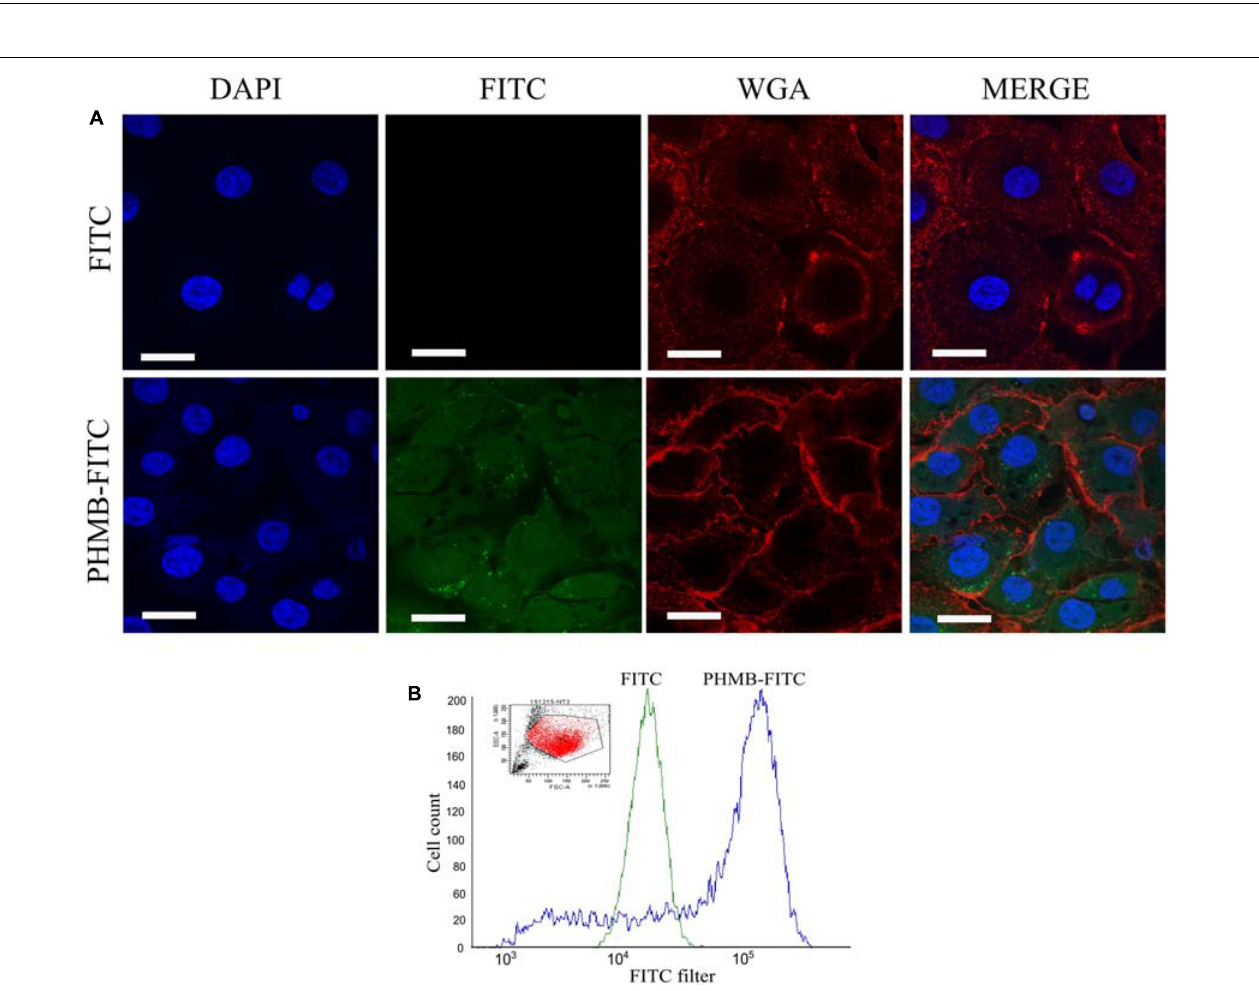
FIGURE 5 | Fluorescein-tagged PHMB ( PHMB-FITC) uptake into Mac-T cells. (A) PHMB-FITC localization visualized by confocal microscopy. Free FITC was used as control. (B) PHMB-FITC uptake was quantified by flow cytometry. The small image represents the population of Mac-T cells gated in the analysis. The overlay histogram image illustrates the uptake of PHMB-FITC into Mac-T cells. The green profile shows the population of cells treated with FITC and serves as a negative control. The blue profile shows the population of cells treated with PHMB-FITC. Uptake of PHMB-FITC was observed in approximately 70% of Mac-T cells.